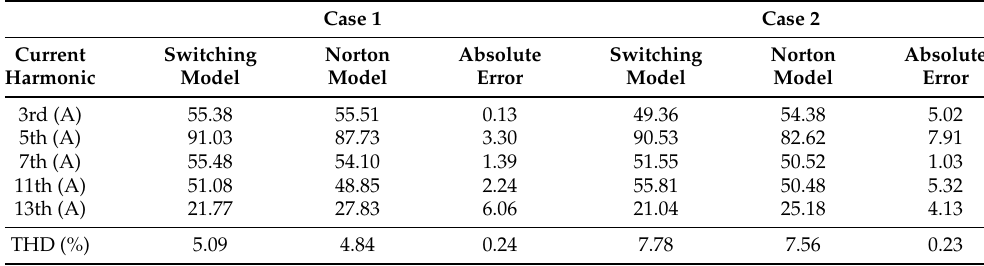
Table 3. Current harmonic injection levels at PCC under Case 1 and Case 2.